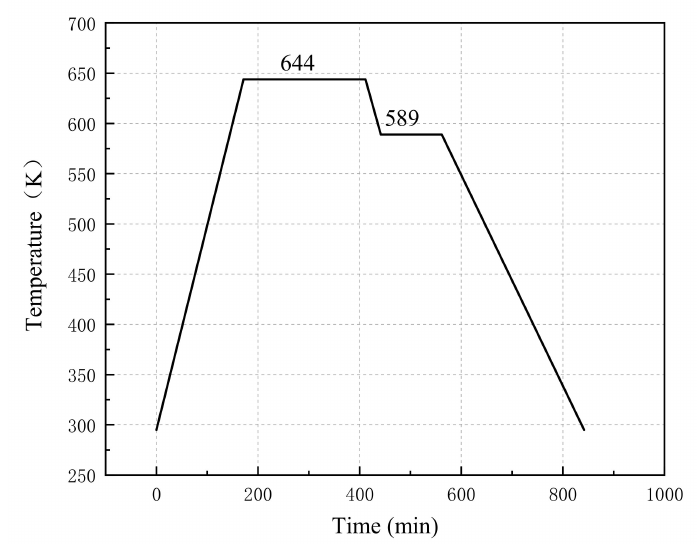
Figure 1. Sintering temperature curve of